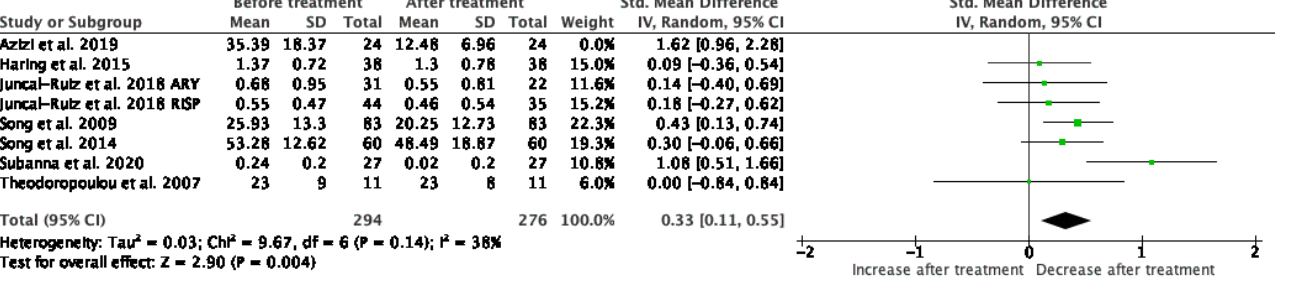
Figure 4. Meta-analysis of IL-1 β .